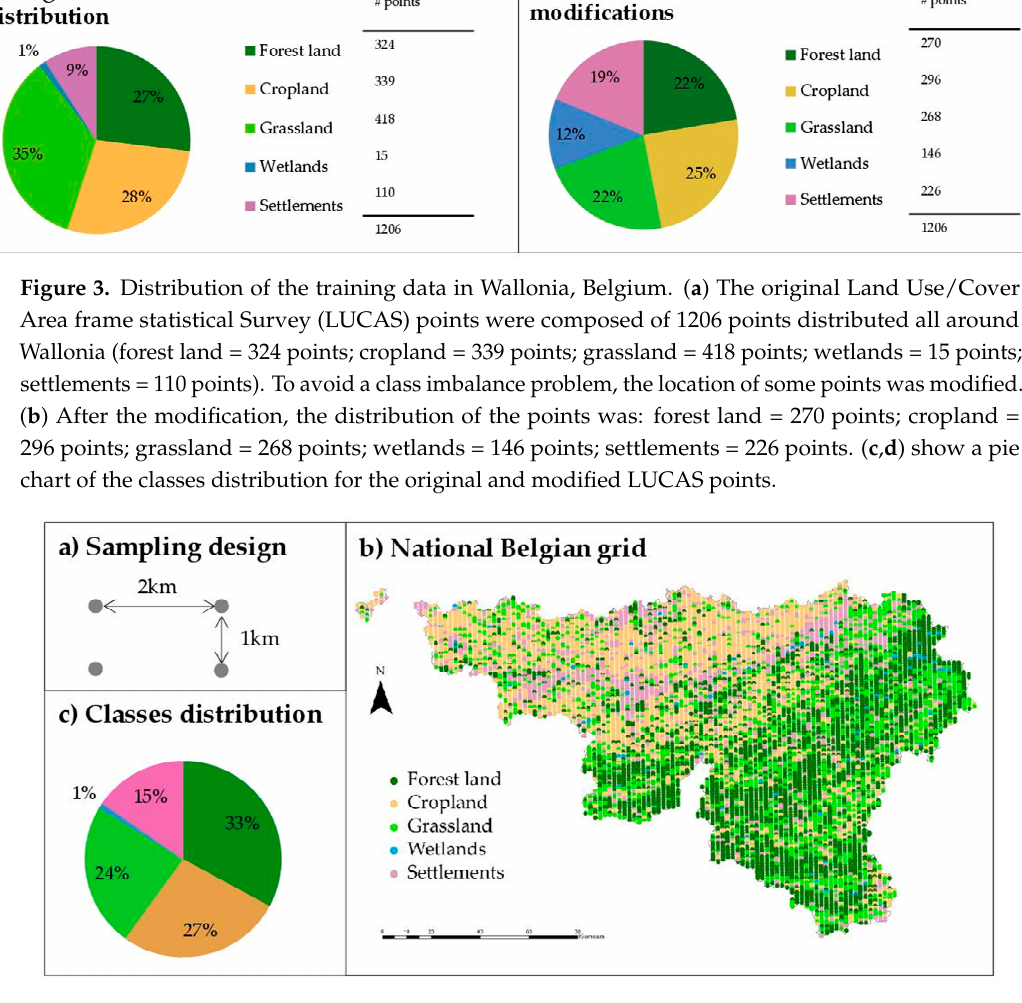
Figure 4. Distribution of the national Belgian grid in Wallonia, Belgium. ( a ) Explanation of the sampling design; ( b ) Distribution of the points. It is composed of 8439 points distributed all around Wallonia (forest land = 2782 points; cropland = 2282 points; grassland = 2002 points; wetlands = 80 points; settlements = 1293 points); ( c ) Pie chart of the classes distribution.